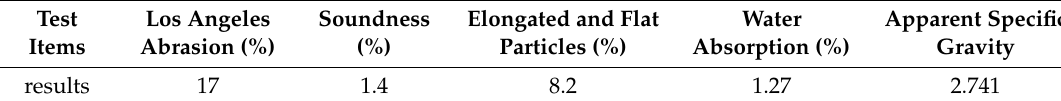
Table 1. Basic physical properties of the aggregate.